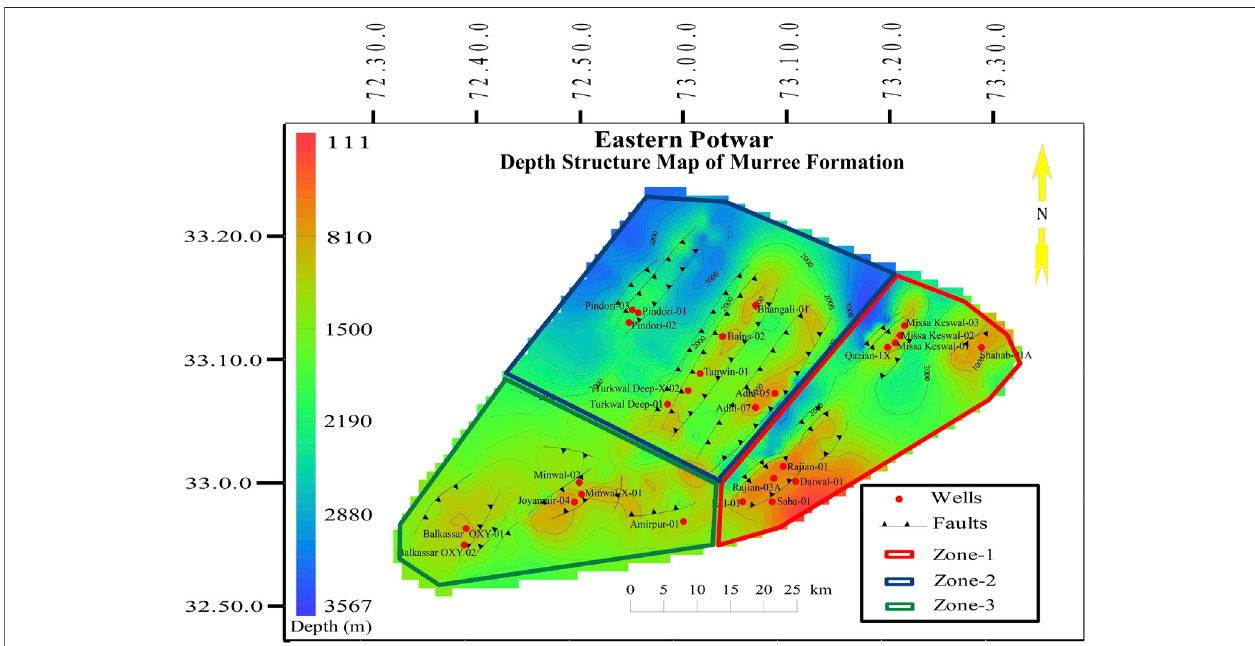
FIGURE 8 | Depth structure map of Murree Formation with interpreted faults trending in northeast to southwest direction. The area is divided into three different zones on the basis of structural geometries, that is, duplex thrust sheets in zone-1 (red polygon), salt-cored anticlines in zone-2 (blue polygon), and zone-3 (green polygon)iscomprisedoftriangular zone (Minwaland Joyamair) and broadbox fold(Balkassar)geometries.Murree Formation lies at averyshallow depth (redcolor fi ll)in zone-1, intermediated depth (green color fi ll) in zone-3 and deepest depth (blue color fi ll) in zone-2.